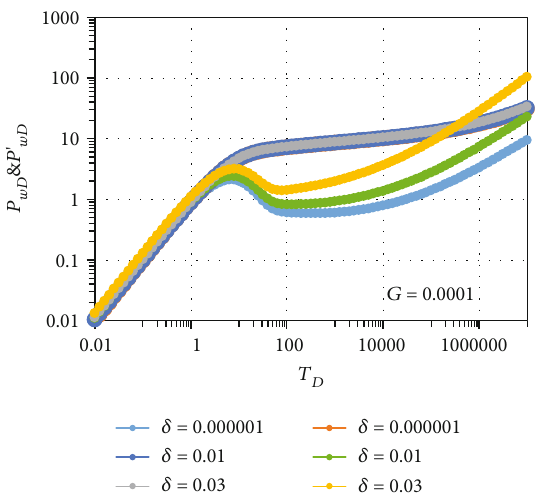
Figure 14: Typical curves considering di ff erent threshold pressure gradients and stress sensitivity.